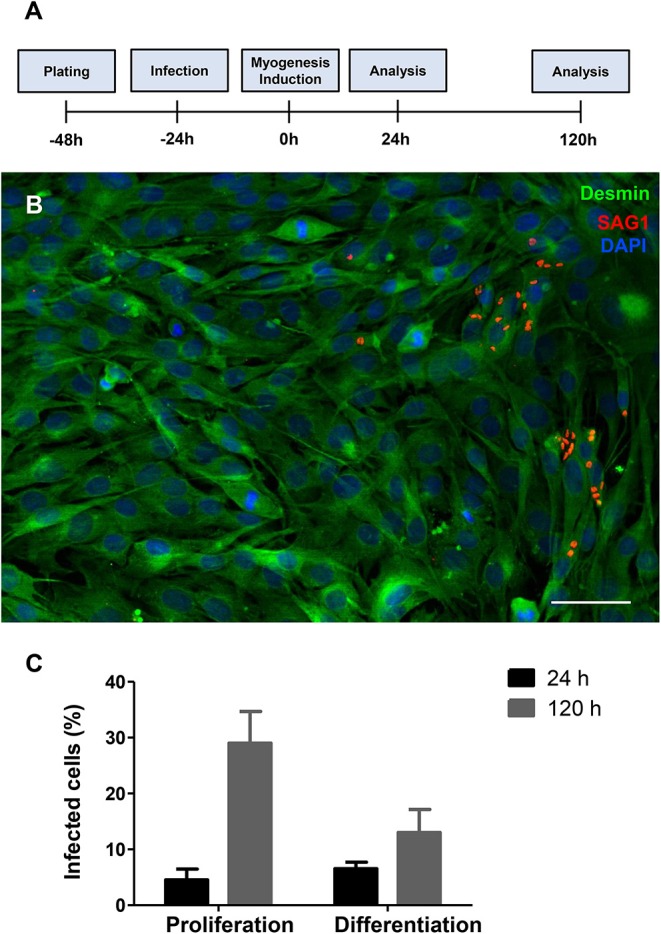
T. gondii infection profile in C2C12 cells. The experimental design is shown in (A) Cells are plated and infected with tachyzoites after 24 h of plating. Then, half of the cultures have their medium changed to DM. Analyses were carried out 24 and 120 h after myogenesis stimulus with DM. Enrichment in muscle cells was confirmed by desmin staining (B, in green) and the presence of tachyzoite forms of T. gondii was detected with anti-SAG1 staining (red) as shown in this representative micrograph of infected cells treated with DM for 24 h. Cells were stained with Giemsa stain and the percentage of infected cells was determined by light microscopy. Graphs in (C) show the average and standard error of three independent experiments. Scale bar = 50 μm.